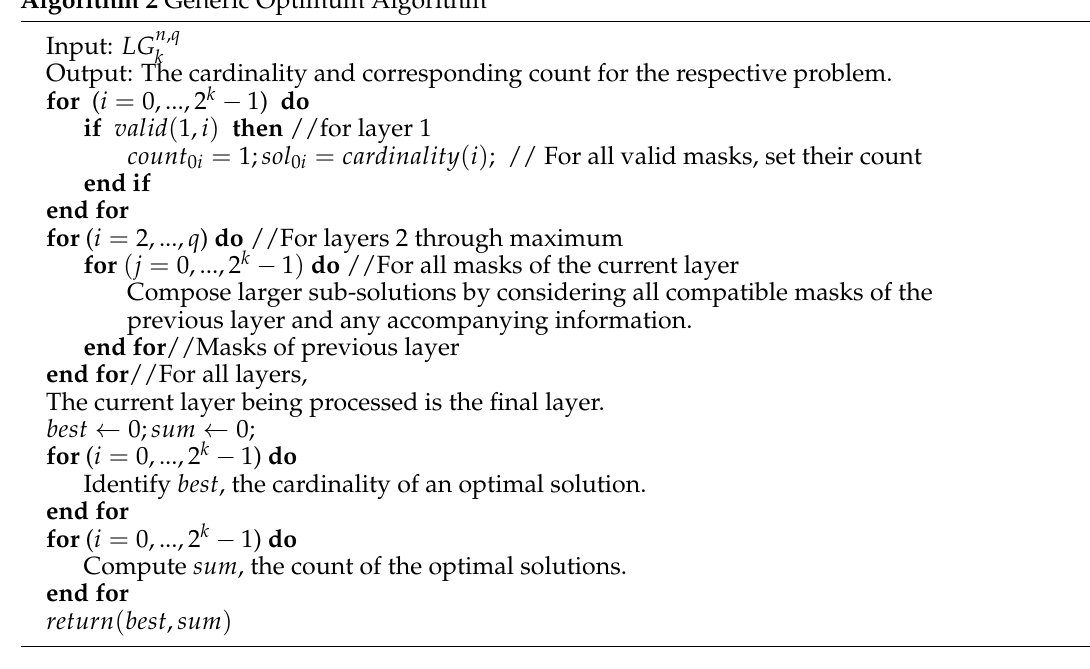
Algorithm 2 Generic Optimum